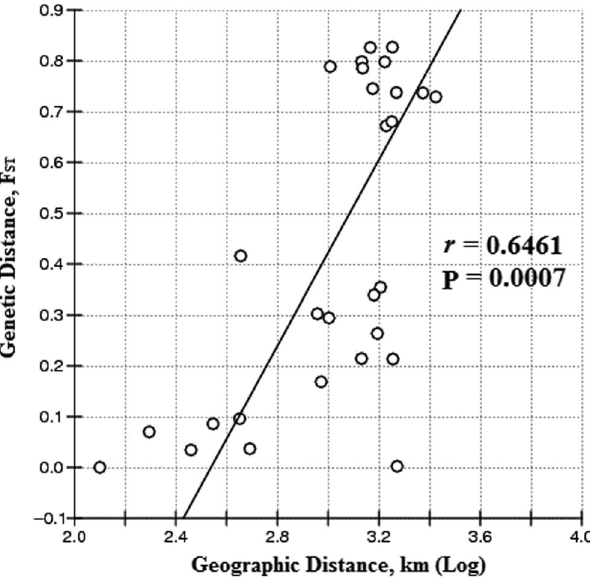
Figure 3. A Mantel test for correlation between genetic distance and geographic